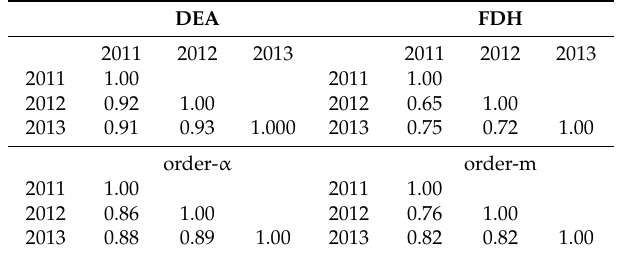
Table 7. Spearman rank correlations for the adjusted scores from each approach across